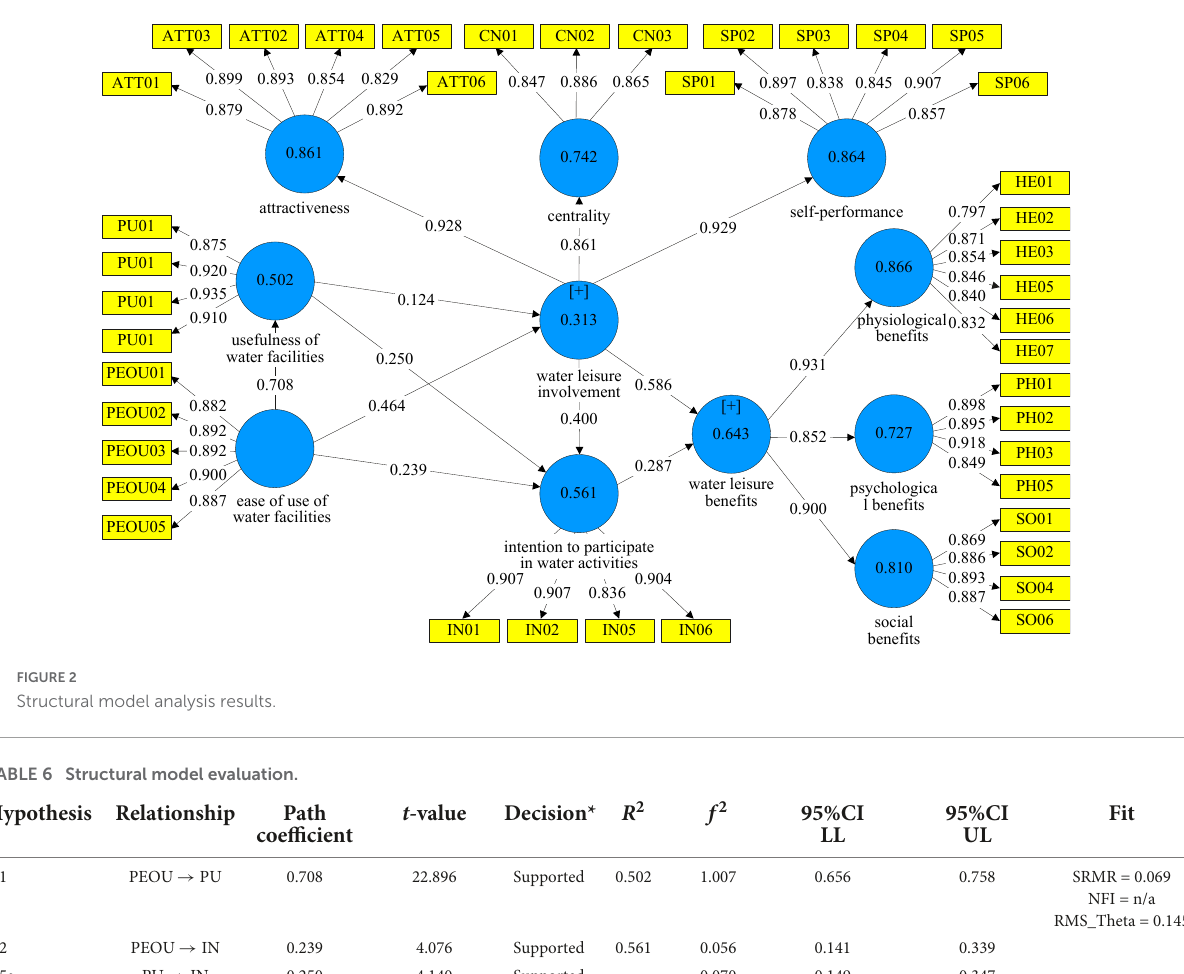
TABLE 6 Structural model evaluation. Hypothesis